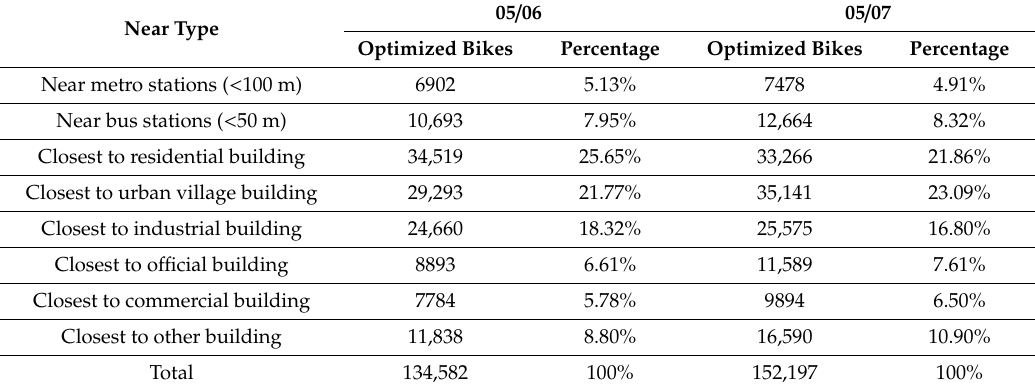
Table 1. The number and percentage of optimized bikes nearby public transportation facilities and different buildings.